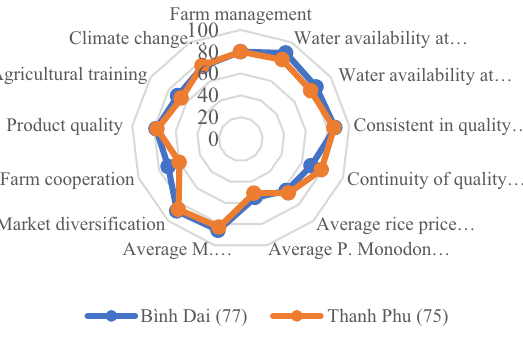
Figure 7. Durability theme assessment of Binh Dai and Thanh